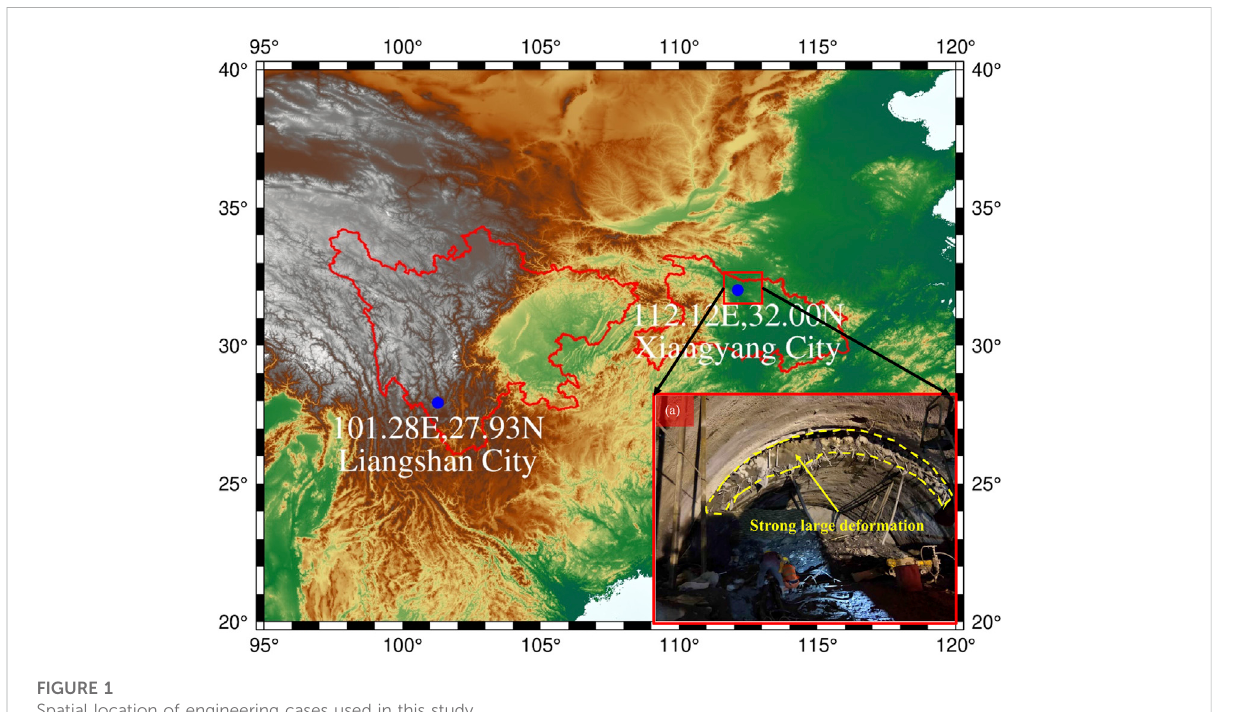
FIGURE 1 Spatial location of engineering cases used in this